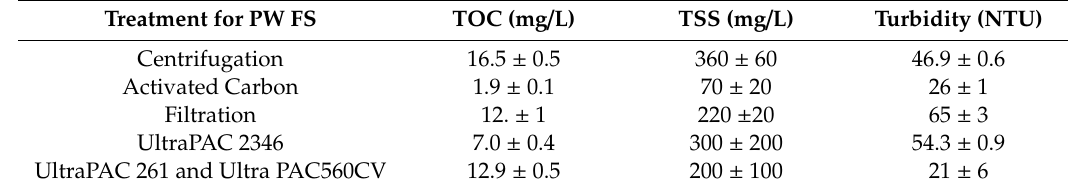
Table 4. Analytical parameters for the 20 L of treated PW used as